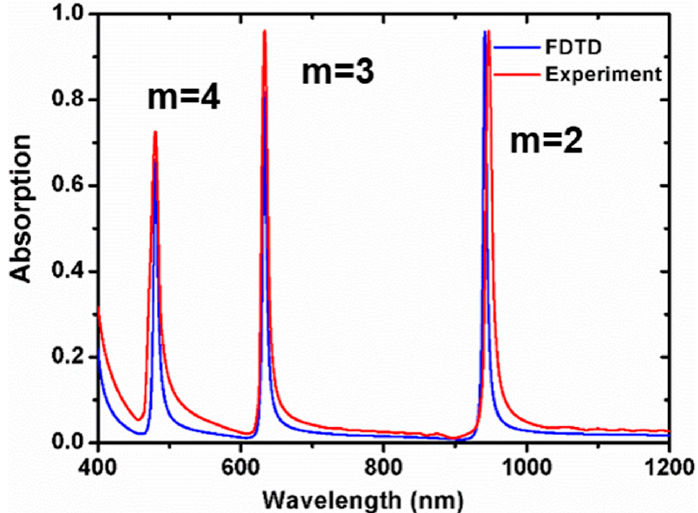
Figure 7. Simulated and experimental absorption for the 100 nm bottom Ag layer, 600 nm middle SiO 2 layer, and 30 nm top Ag layer.